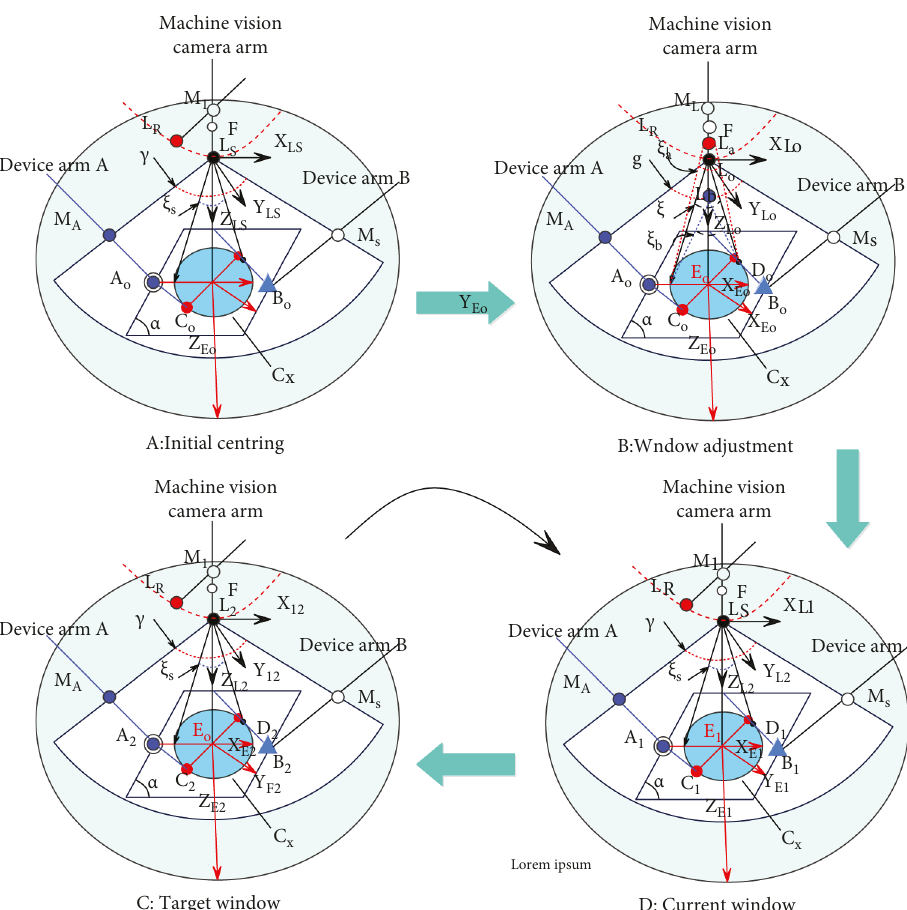
Figure 1: Schematic diagram of the window replacement process of the window tracking algorithm of the machine vision